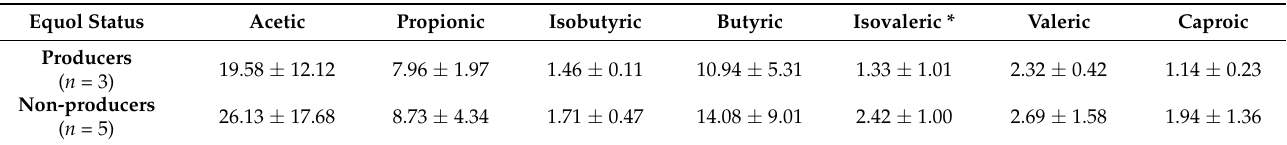
Table 3. Differences in fecal FAs between equol producers and non-producers after isoflavone supplementation. Equol Status Acetic